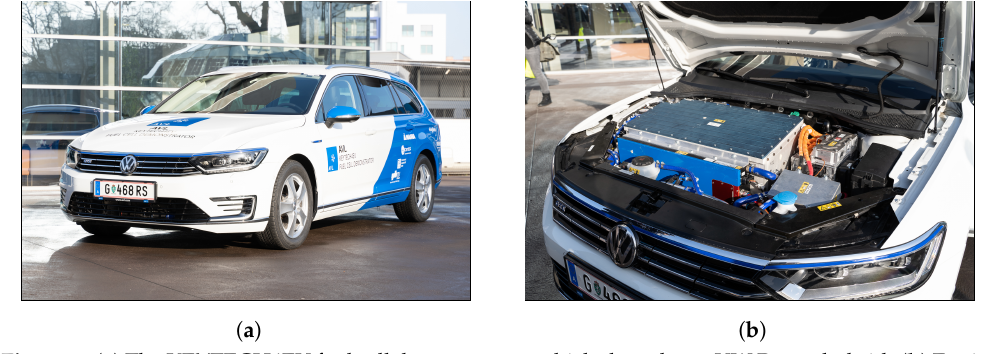
Figure 1. ( a ) The KEYTECH4EV fuel cell demonstrator vehicle, based on a VW Passat hybrid. ( b ) Engine bay with the retro-fitted fuel cell system. Table 1. FC demonstrator vehicle